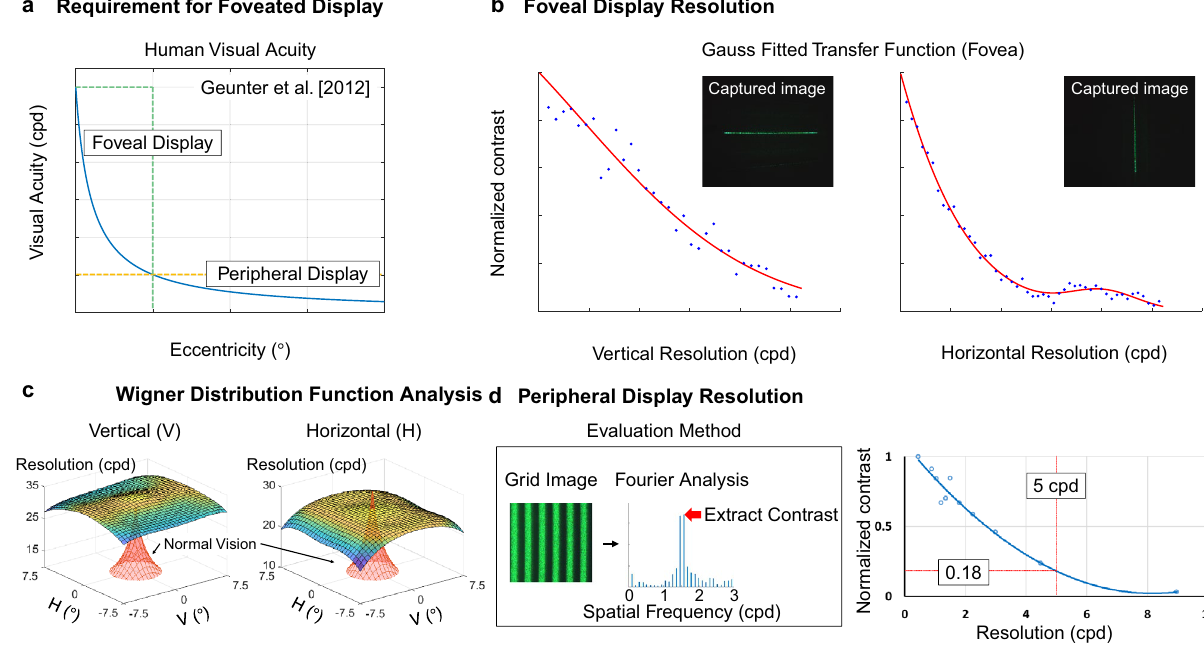
Figure 6. Resolution analysis and evaluation of the foveated near-eye display. ( a ) Requirement of foveated display to meet the resolution limit of human visual acuity. ( b ) Experimental evaluation of resolution limit of the foveal display. ( c ) The resolution limit of the foveal display is analyzed and compared with the human visual acuity using Wigner distribution function 17 . ( d ) Experimental evaluation of resolution limit of the peripheral display.